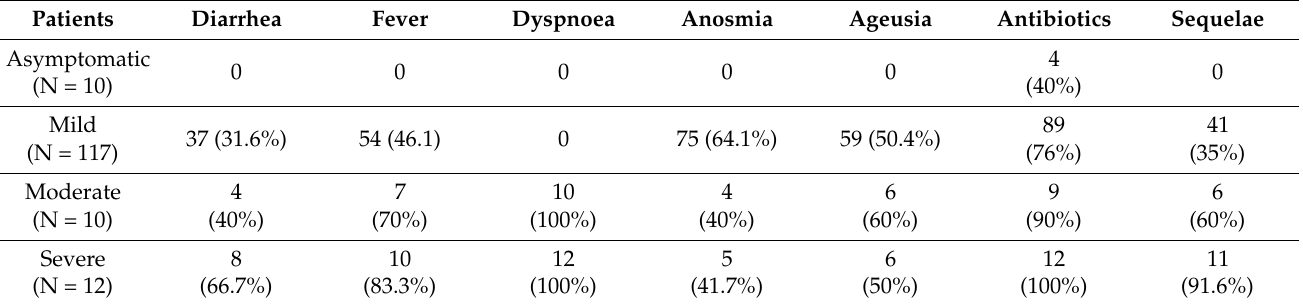
Table 2. Distribution of main symptoms and antibiotic therapy, based on disease severity classifica- tion, during the acute phase, besides sequelae in post-COVID-19 patients.